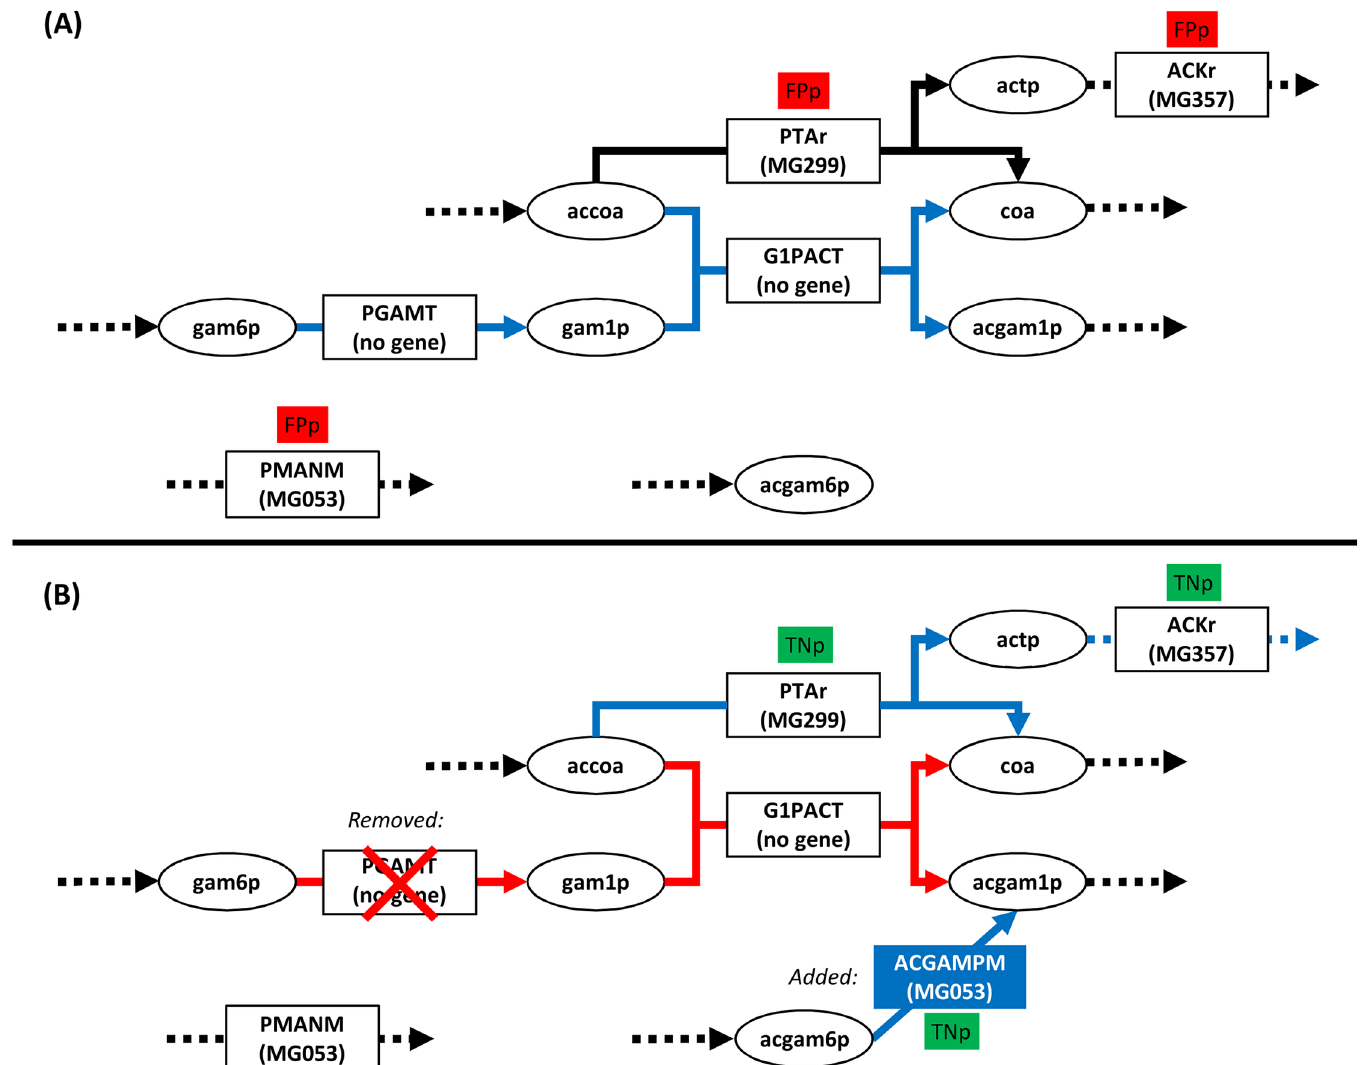
Fig 1. An example for the utility of simultaneously adding and removing reactions. Ellipses indicate metabolites, rectangles indicate reactions; abbreviations are taken from iPS189 [21]. (A) N-Acetyl-D-glucosamine 1-phosphate (acgam1p) is produced by G1PACT; MG053, MG299, and MG357 are falsely predicted to be non-essential (FPp). (B) The simultaneous removal of PGAMT (or, alternatively, G1PACT) and addition of ACGAMPM makes the genes MG053, MG299, and MG357 essential. Blue arrows mark essential pathways, while red arrows indicate blocked pathways. Note that removing either one of PGAMT or G1PACT blocks the other reaction, and that both reactions are not associated with any